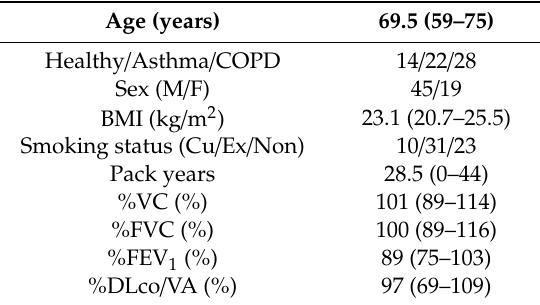
Table 1. Characteristics of the study subjects.